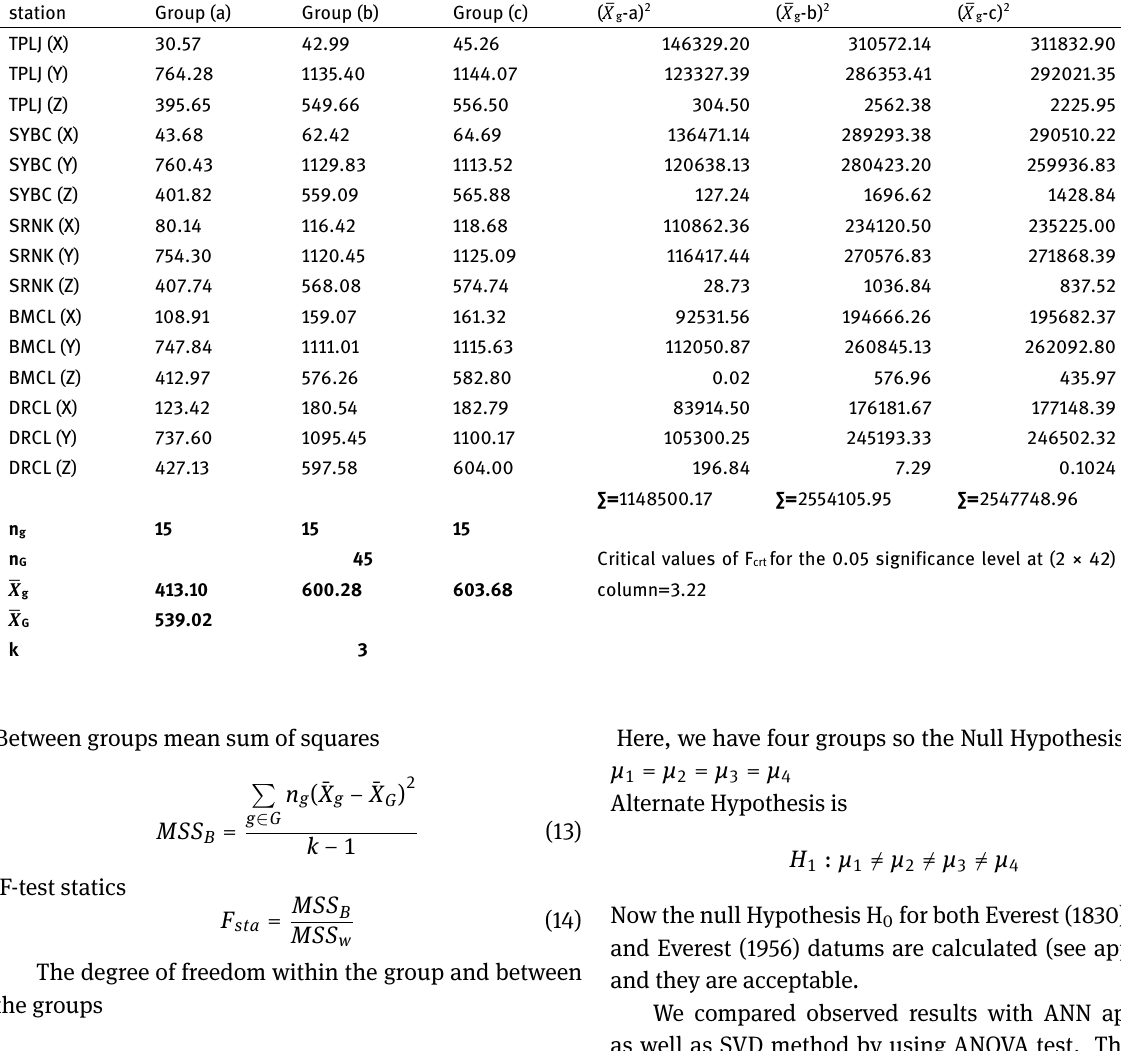
Table 2: ANOVA test for Everest (1830) datum